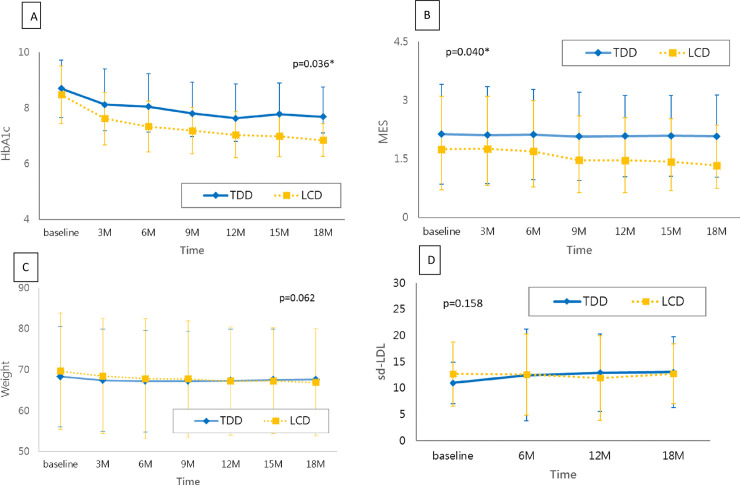
18-month changes across dietary intervention groups.(A) HbA1c (%) and (B) MES were significantly different (p<0.05) between the TDD and LCD groups. However, the differences in (C) weight (Kg) and (D) sd-LDL (mg/dl) were not significant between the TDD and LCD groups (p>0.05).